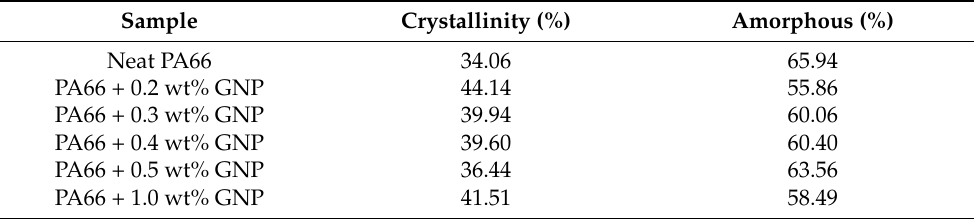
Table 4. Crystallinity degrees of neat PA66 and its GNP-based nanocomposites obtained from DSC characterization.